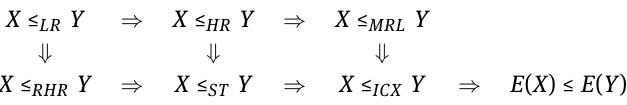
Table 1: Relationships among univariate stochastic